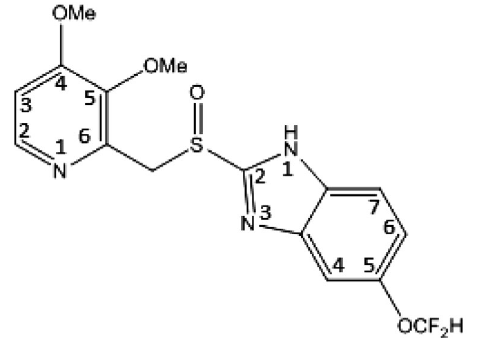
Figure 1. Structure of